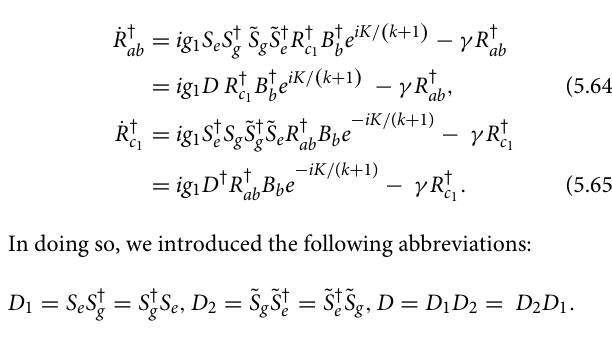
FIGURE 10 | Damped temporal curves showing the overlay of the real (gray) and imaginary (red) parts of the operators B † p are consecutively outlined through steps 1–4. The algebraic equivalents